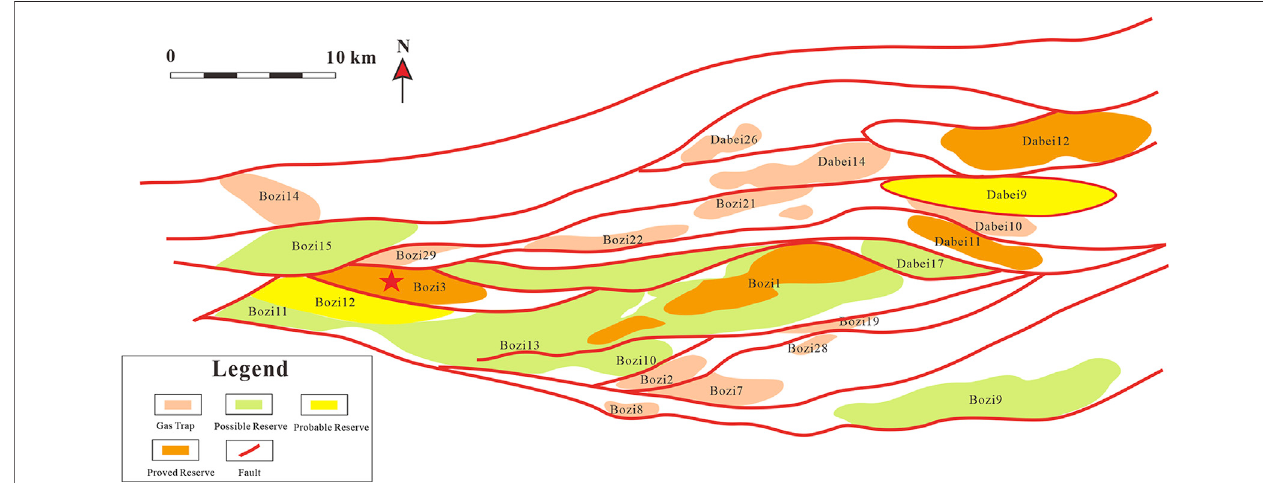
FIGURE 1 | Exploration map of the Bozi gas area.